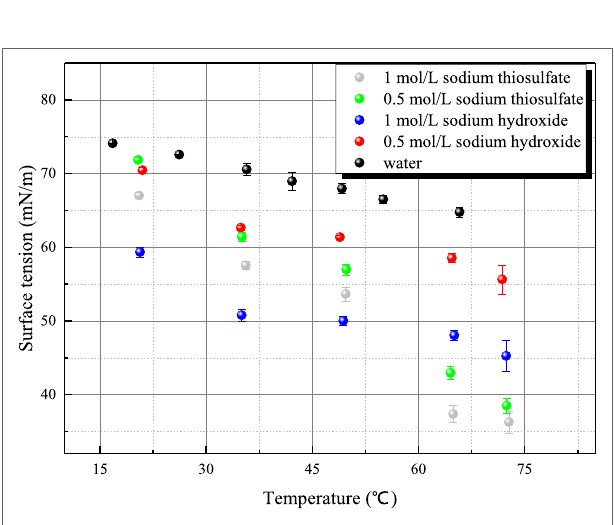
FigUre 8 | The influence of agitation on the surface tension of sodium hydroxide (sodium hydroxide concentration is 1 mol/L; solution temperature is 73°C).